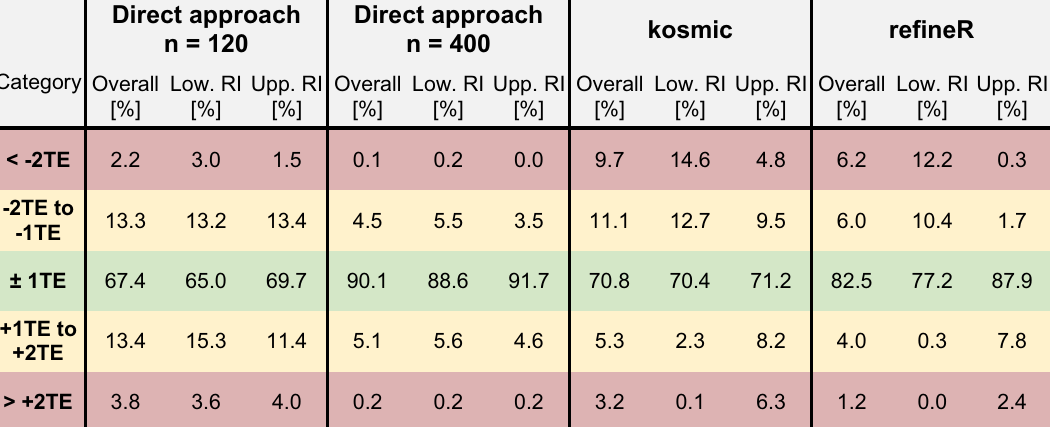
Table 2. Summary table with comparison of quality of results for all analyzed test cases. The table shows for all considered methods (direct method with n = 120 and n = 400, kosmic and refineR algorithm) the overall distribution of RI estimates for the six simulated analyte distributions in the five evaluation categories (see “Methods” Table 1). The results are shown for the lower and upper reference interval as well as an average of both options for the overall amount. TE total error, RI reference